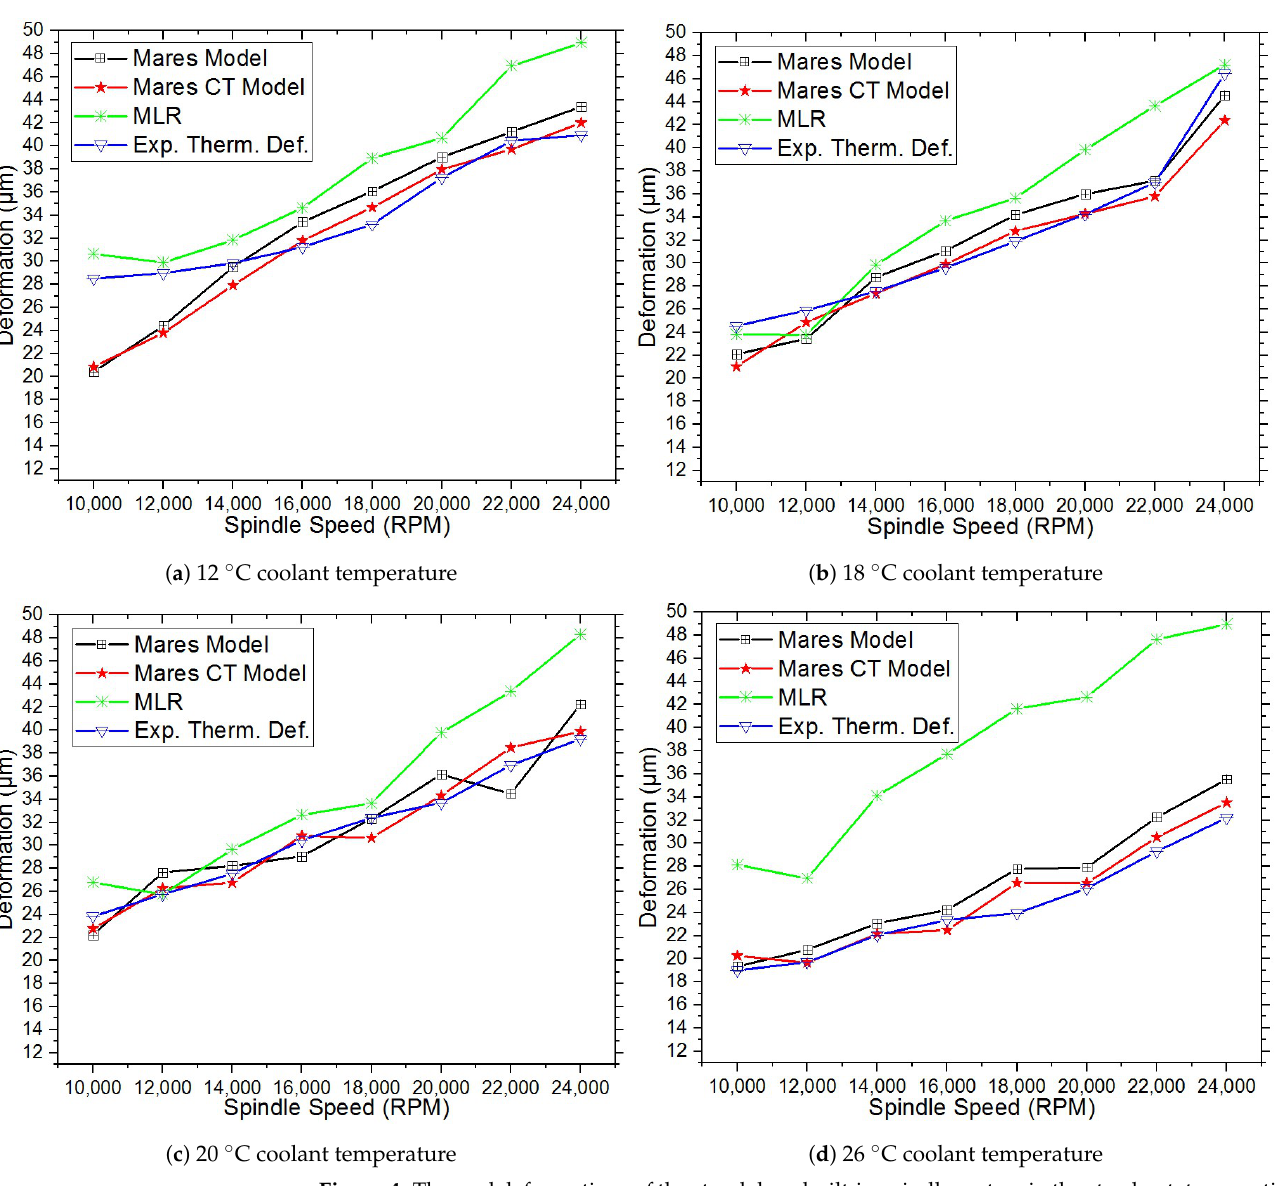
Figure 4. Thermal deformations of the standalone built-in spindle system in the steady-state operation at the different coolant temperatures and the spindle rotating speeds with a constant coolant flow rate of 5 LPM: ( a ) 12 ◦ C coolant temperature; ( b ) 18 ◦ C coolant temperature; ( c ) 20 ◦ C coolant